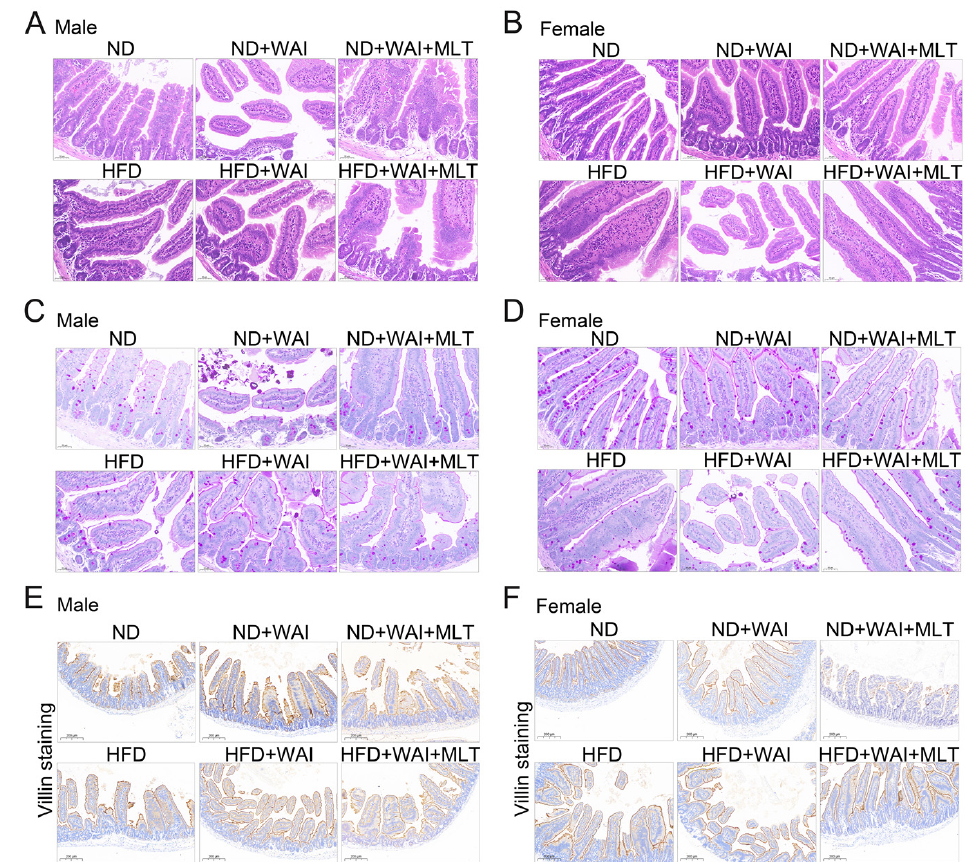
Figure 2. MLT promotes small intestinal structure repair in mice following WAI. Representative H&E staining of small intestinal structures from male ( A ) and female ( B ) mice (20 × magnification). Representative PAS staining of small intestinal structures from male ( C ) and female ( D ) mice (20 × magnification). Representative immunohistochemical images of villi + in the small intestinal structure from male ( E ) and female ( F ) mice (10 × magnification). (MLT, melatonin; H&E, hematoxylin and eosin; PAS, periodic acid-Schiff; WAI, whole abdominal irradiation).